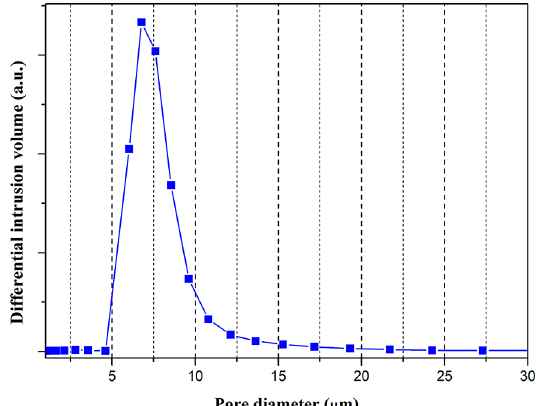
Figure 5. Pore size distribution of the alumina substrate by mercury intrusion porosimetry.